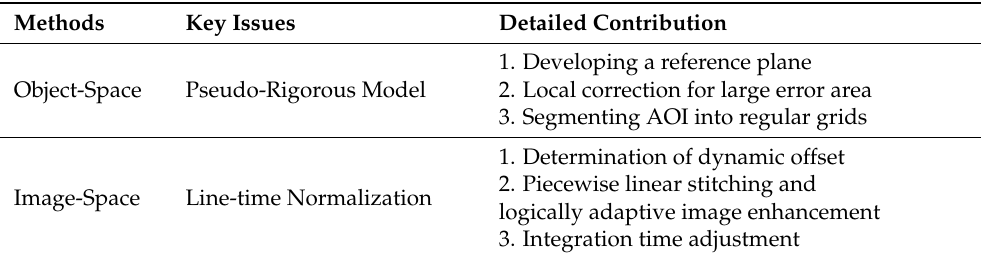
Table 2. Main characteristics of the traditional